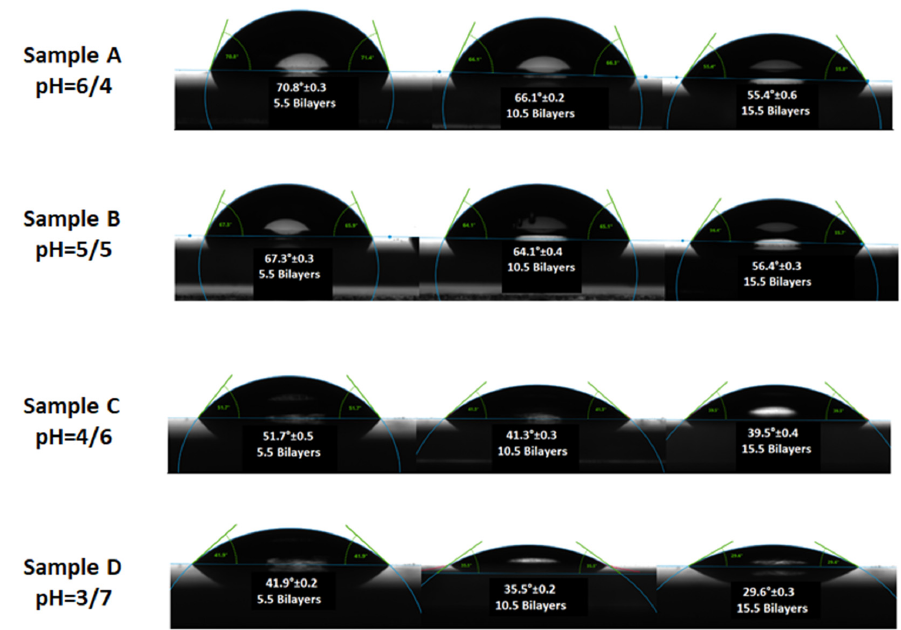
Figure 11. Contact angle measurement of thin film gradients at various pH combinations.